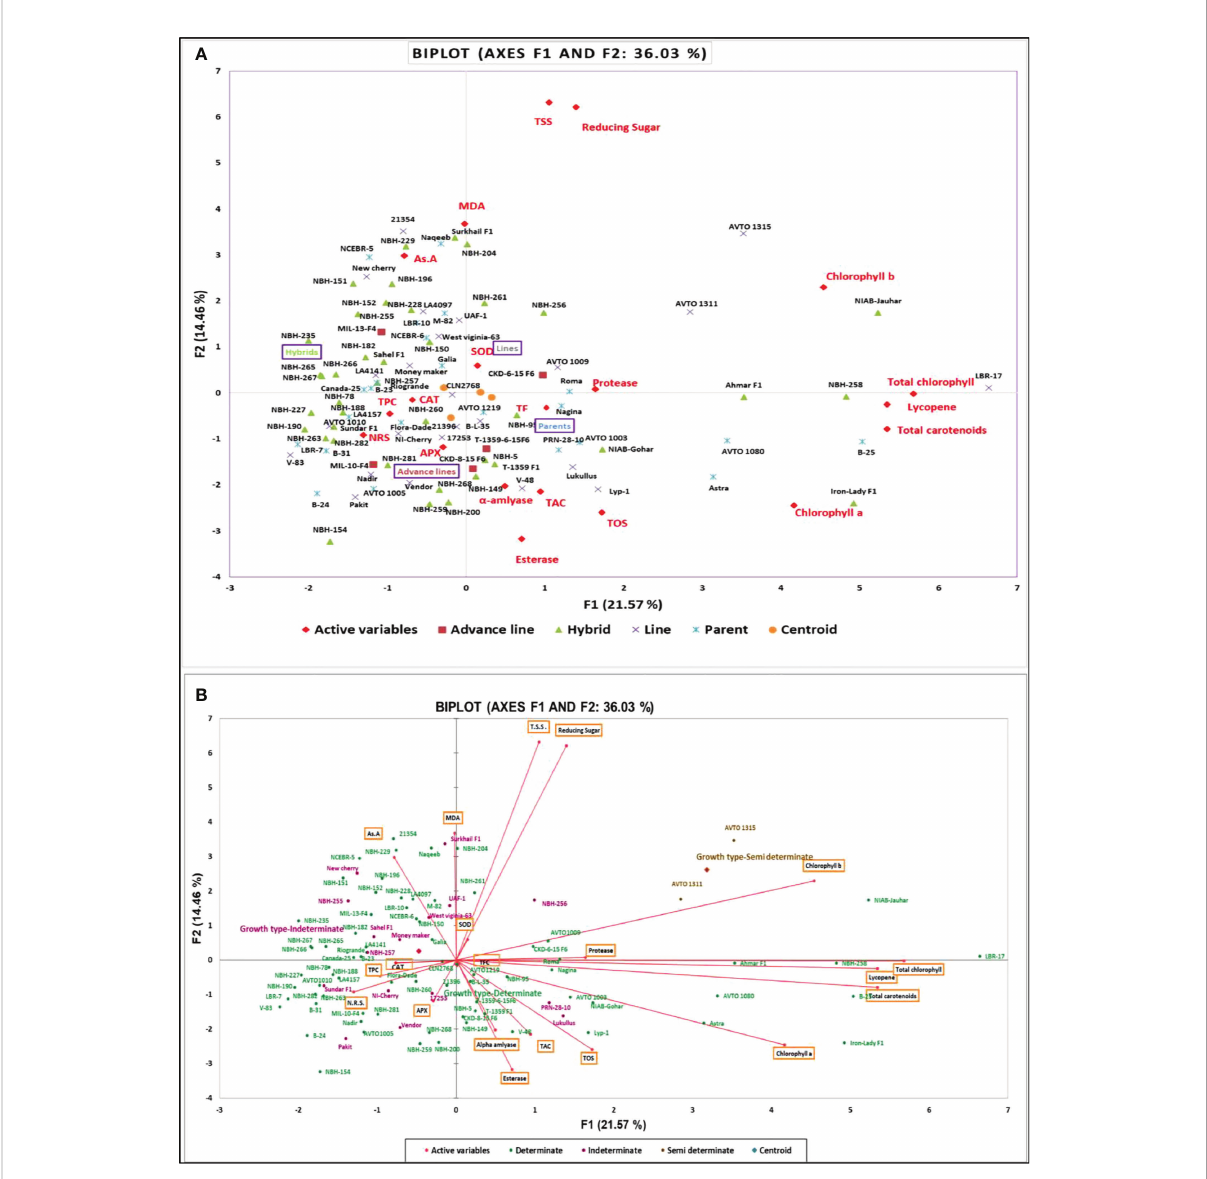
FIGURE 9 Biplot of the tomato genotypes for fi rst two principal components (A) representing centroids of categories hybrid, parents, lines and advance line, and (B) representing centroids for growth habit determinate, indeterminate and